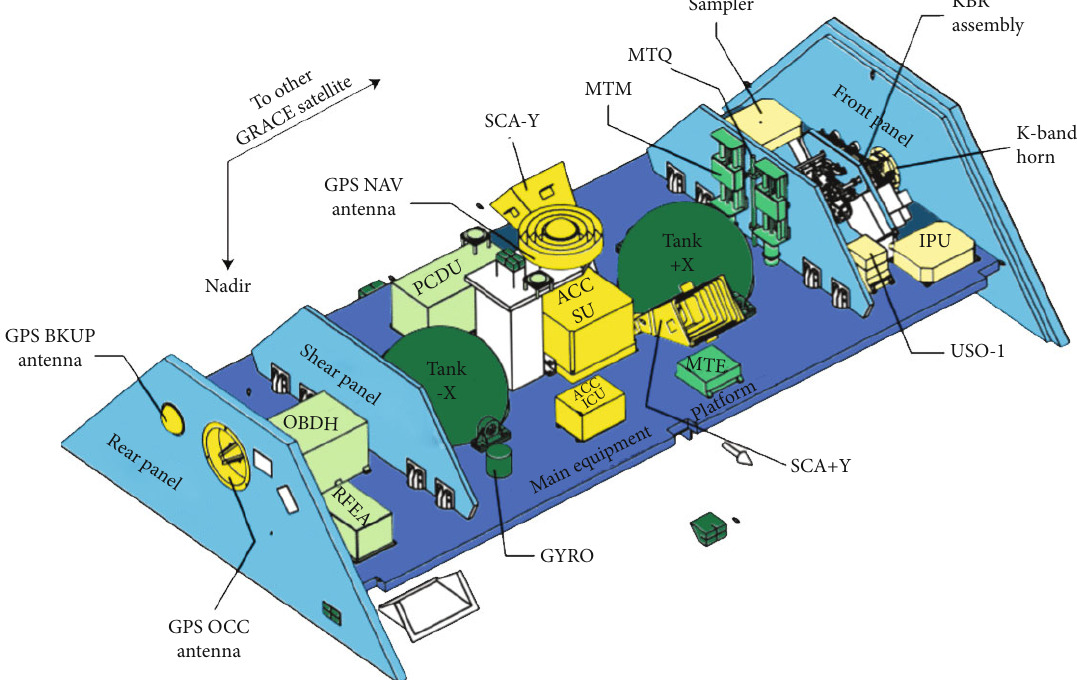
Figure 1: Position of GPS antenna position and type of the GRACE spacecraft